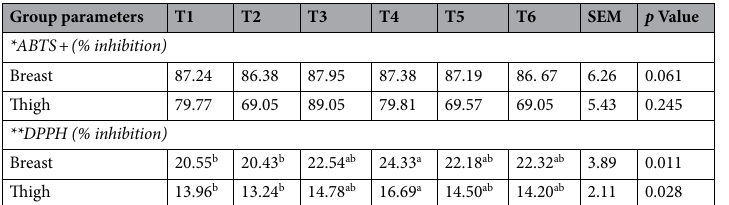
Table 5. Effects of dietary supplementation of prebiotics on anti-oxidant parameters of fresh meat in broiler chickens. T1 (no MOS/FOS/BMD), T2 (0.002% BMD), T3 (T1 + 0.1% MOS), T4 (T1 + 0.2% MOS), T5 (T1 + 0.1% FOS), T6 (T1 + 0.2% FOS). Mean values bearing the same superscript in a row did not differ significantly ( p < 0.05). ABTS + = 2,2azino-bis -3-ethyl benzothiazoline-6-sulfonic acid; DPPH = 2, 2-diphenyl- 1-picrylhydrazyl. SEM = Standard error of mean; NS = Non-significant; n = 15.